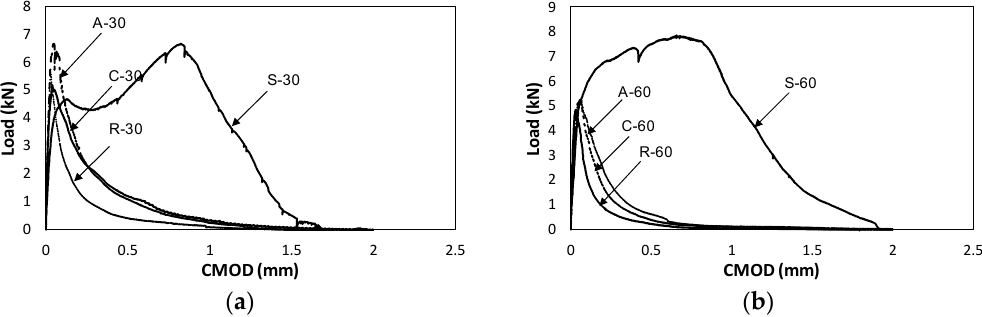
Figure 13. Elapsed time versus decremented fraction of fracture energy: ( a ) true fracture energy ( G F ); and ( b ) size effect fracture energy ( G f ).